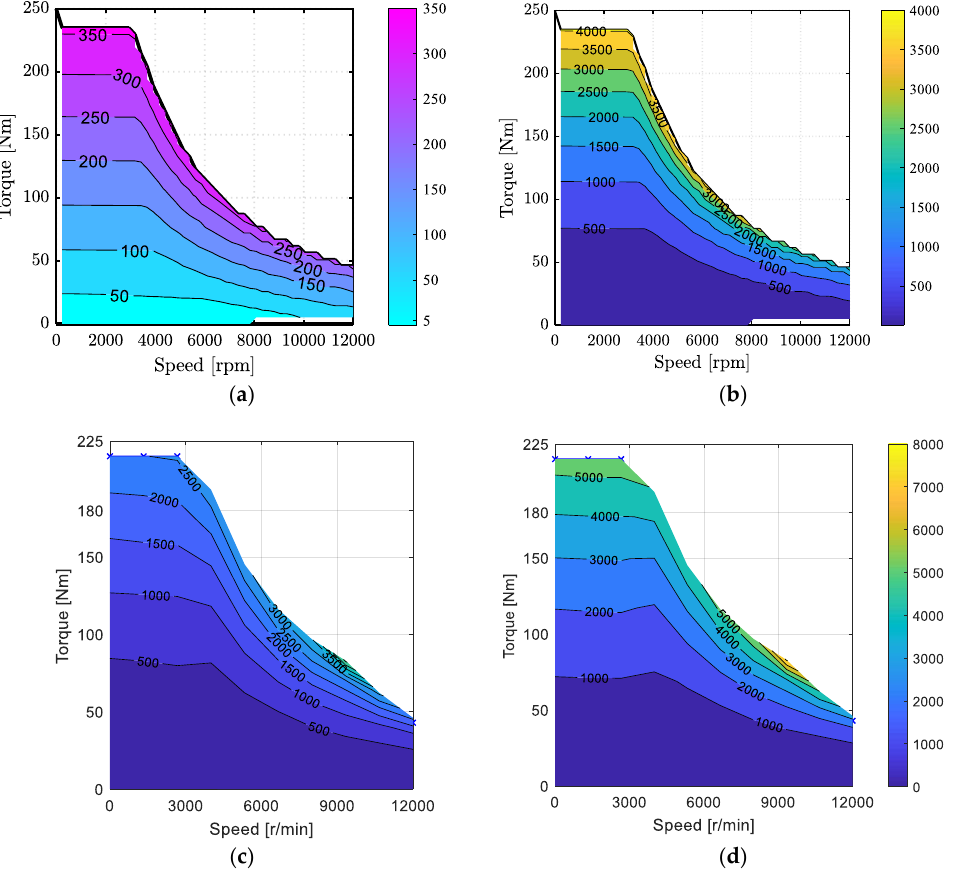
Figure 5. Current and ohmic loss maps of a 50 kW IPMSM for operation over a wide torque speed range [20,24] and the contour plot of ohmic losses of a 60 kW induction machine (rotor bar and stator ohmic loss) [21]. These plots have been provided based on the collected data from [20,21,24]. ( a ) current map in the torque speed plane. ( b ) ohmic loss map in the torque speed plane. ( c ) IM rotor bar loss. ( d ) IM stator loss.